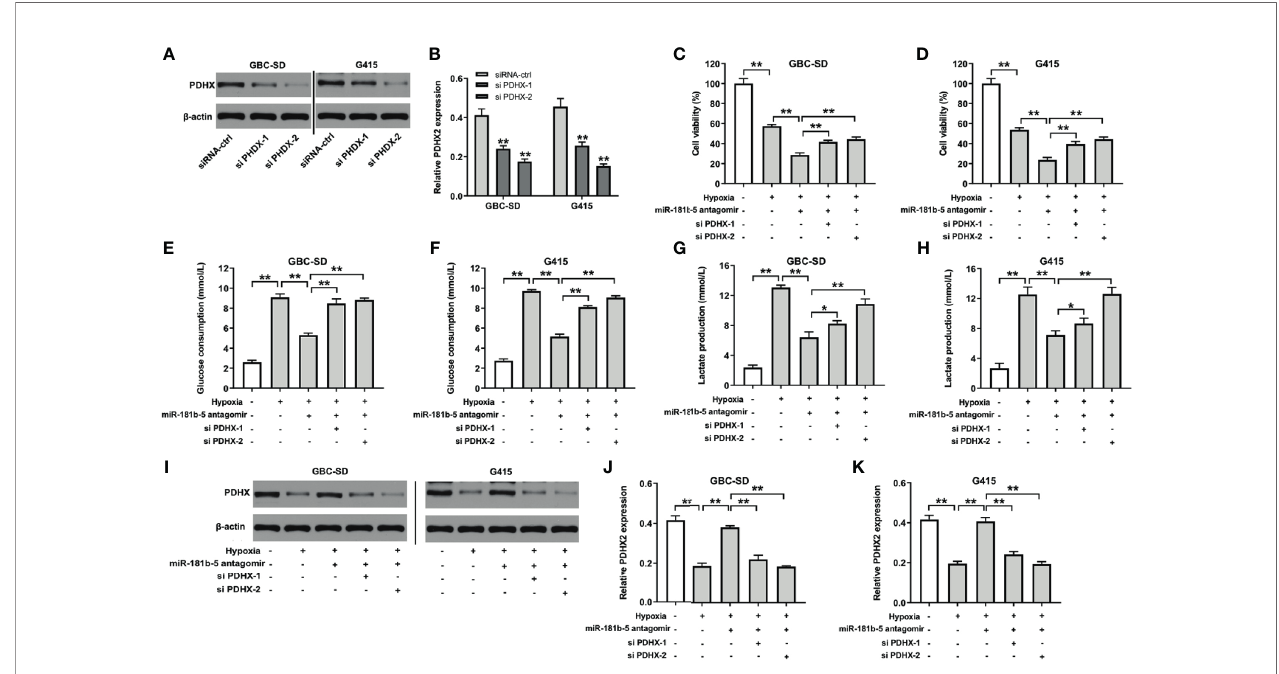
FIGURE 6 | Downregulation of miR-181b-5p inhibits the viability, migration, and glycolysis of GBC by upregulating PDHX under hypoxia. (A, B) Western blotting was used to determine the level of PDHX in GBC cells. (C, D) CCK-8 assay was used to detect GBC cell viability. (E – H) Glucose Assay Kit or Lactic Acid assay kit was performed to detect the level of glucose consumption or lactate production in the supernatant. (I – K) Western blotting was used to determine the level of PDHX. *P < 0.05, **P < 0.01 compared with control group, n =